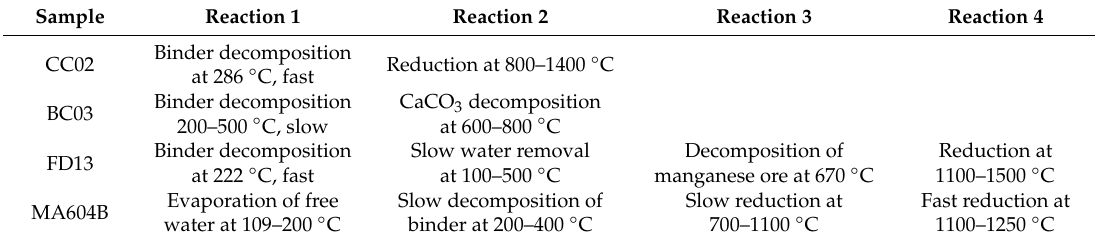
Table 5. Summary of TGA-MS results.